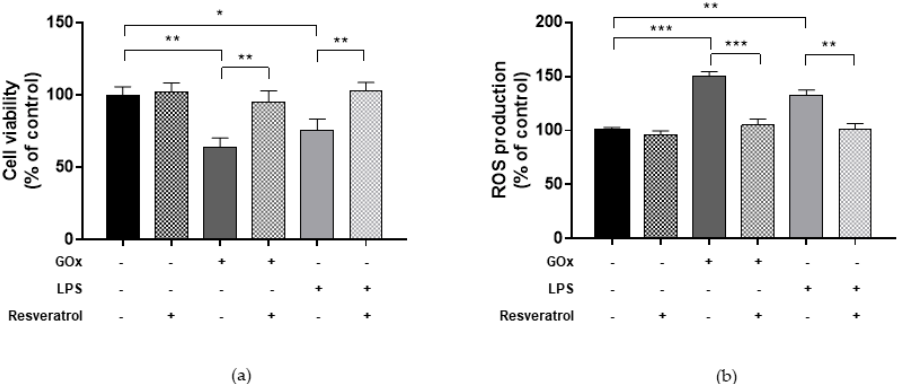
Figure 1. Cell viability and reactive oxygen species (ROS) production in human retinal pigment epithelial (ARPE-19) cells under oxidative stress and inflammatory conditions. ( a ) Thiazolyl blue tetrazolium bromide (MTT) assay showed that treatment with 25 mU/mL glucose oxidase (GOx) or 10 µg/mL lipopolysaccharide (LPS) for 24 h reduced cell viability by 35.8% ( p = 0.004) and 24.2% ( p = 0.035), respectively. ( b ) The determination of ROS using 2 ′ ,7 ′ -dichlorofluorescin diacetate (DCFDA) demonstrated higher ROS production in GOx- and LPS-treated cells compared to controls (50.1%, p < 0.001; 32.6%, p = 0.004; respectively). Resveratrol restores ( a ) viability and ( b ) ROS production in cells under oxidative and inflammatory conditions. The experiments were performed in triplicate and repeated three times. Bar graphs show mean ± SE. * p < 0.05, ** p < 0.01, *** p < 0.001 based on the Student’s t -test.